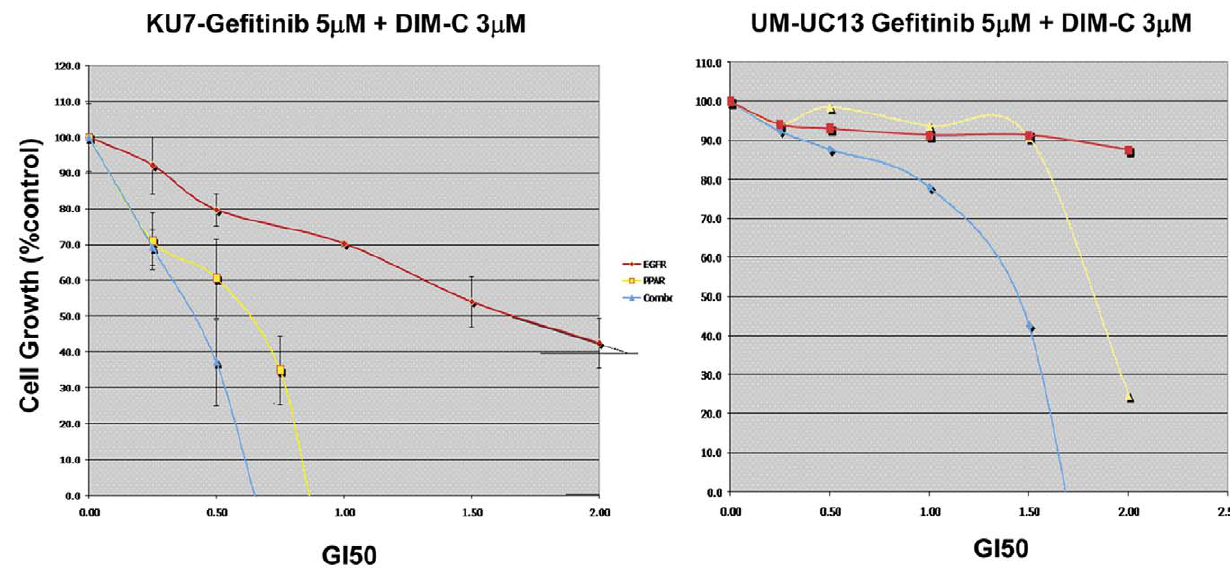
Figure 2. Antiproliferative effects of combined therapy. Growth was monitored by MTT assays. Cells were treated with gefitinib 5 m M and DIM-C 3 m M and compared to each drug alone. Red: gefitinib; Yellow: DIM-C; Blue: gefitinib +